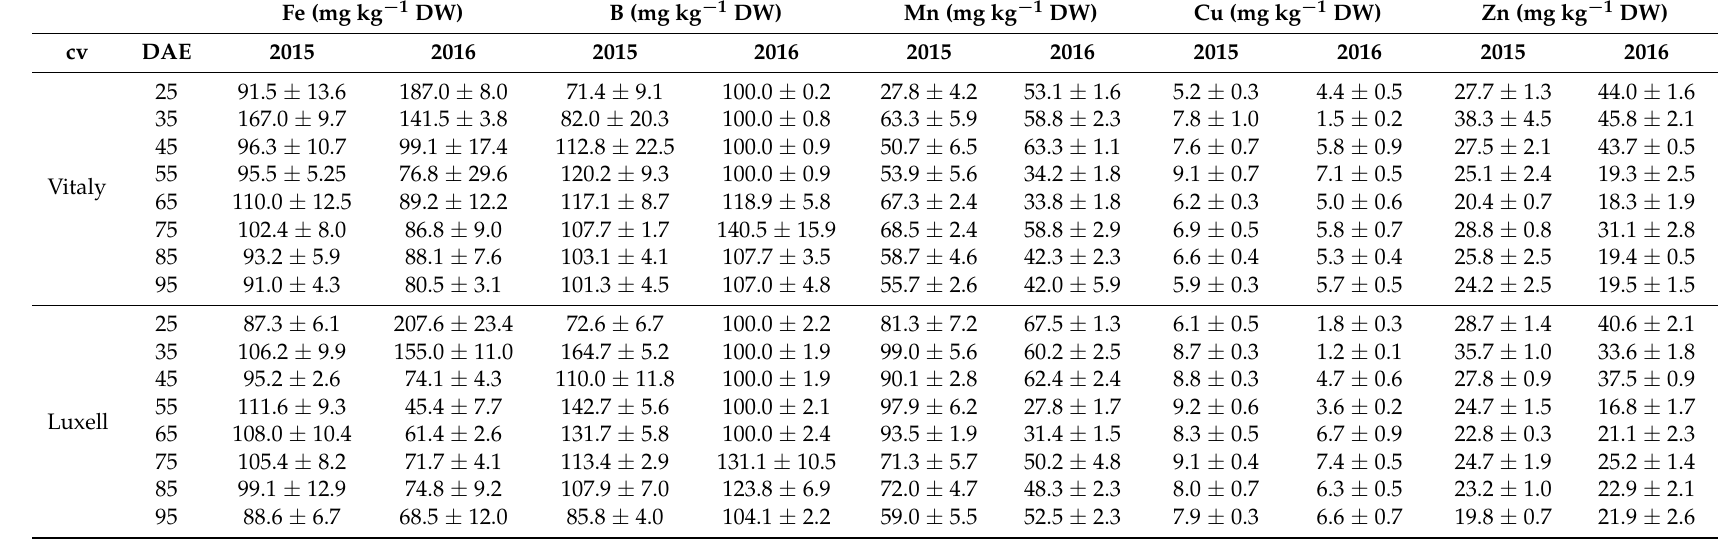
Table 1. Concentration of micronutrients in whole plant determined during the development of cucumber in Vitaly and Luxell